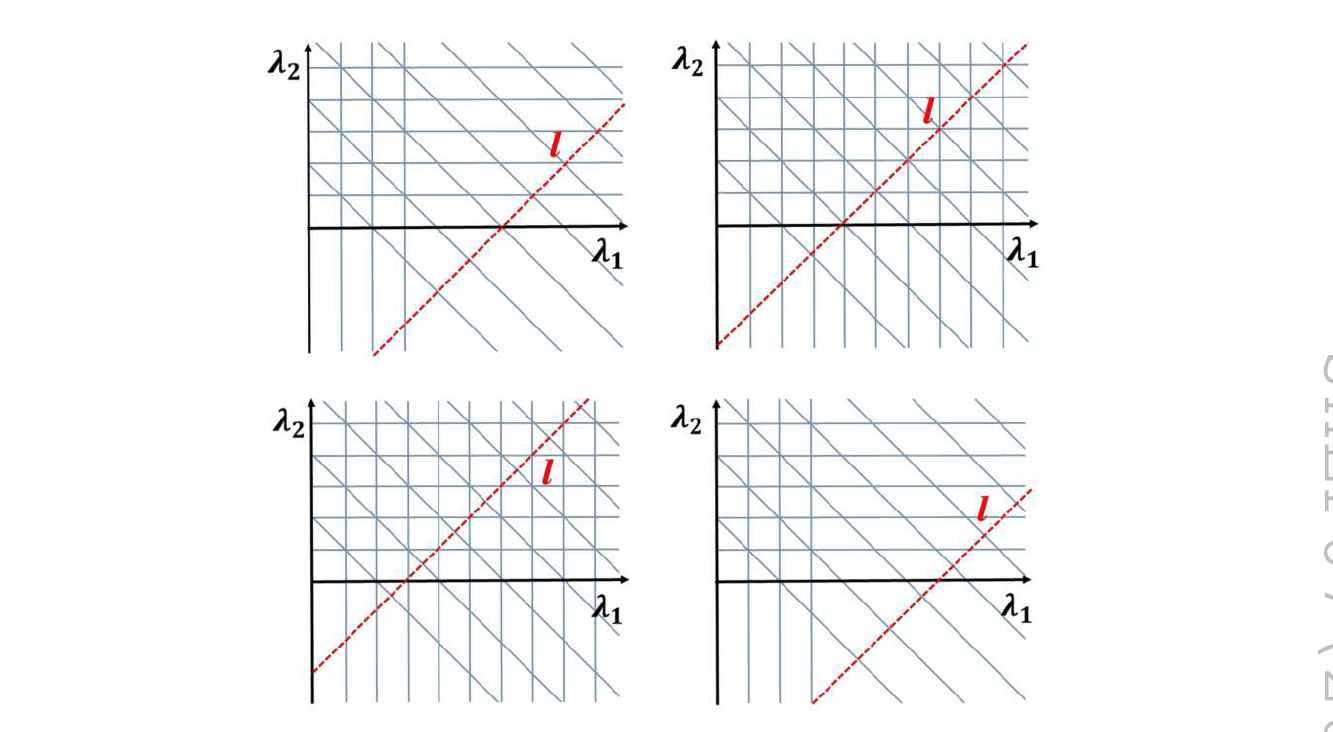
Figure 5 . Illustration of the poles positions in case A-D. The three sets of blue lines depict the position of singularities for the three different series with e 1 singularities along the vertical lines, e 2 along horizontal and e 1 + e 2 along diagonal lines. Note that in cases A and D there is a finite number of e 1 singularities. The dotted red lines depict the choice of spin l , i.e. they run along the curves λ 2 = λ 1 l ǫ/ 2. For a fixed choice of l we see those as the singularities that lie on the − − red lines. In several cases these involve collisions of two or even three poles. The corresponding conformal weight at which the singularity occurs is determined as ∆ = d/ 2